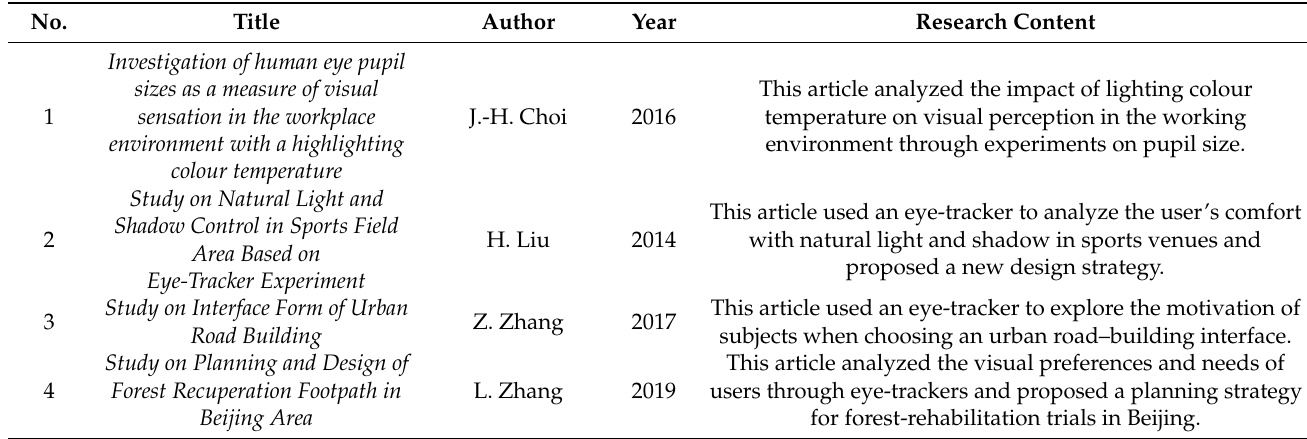
Table 3. Literature review of eye-movement behaviour and architectural visual